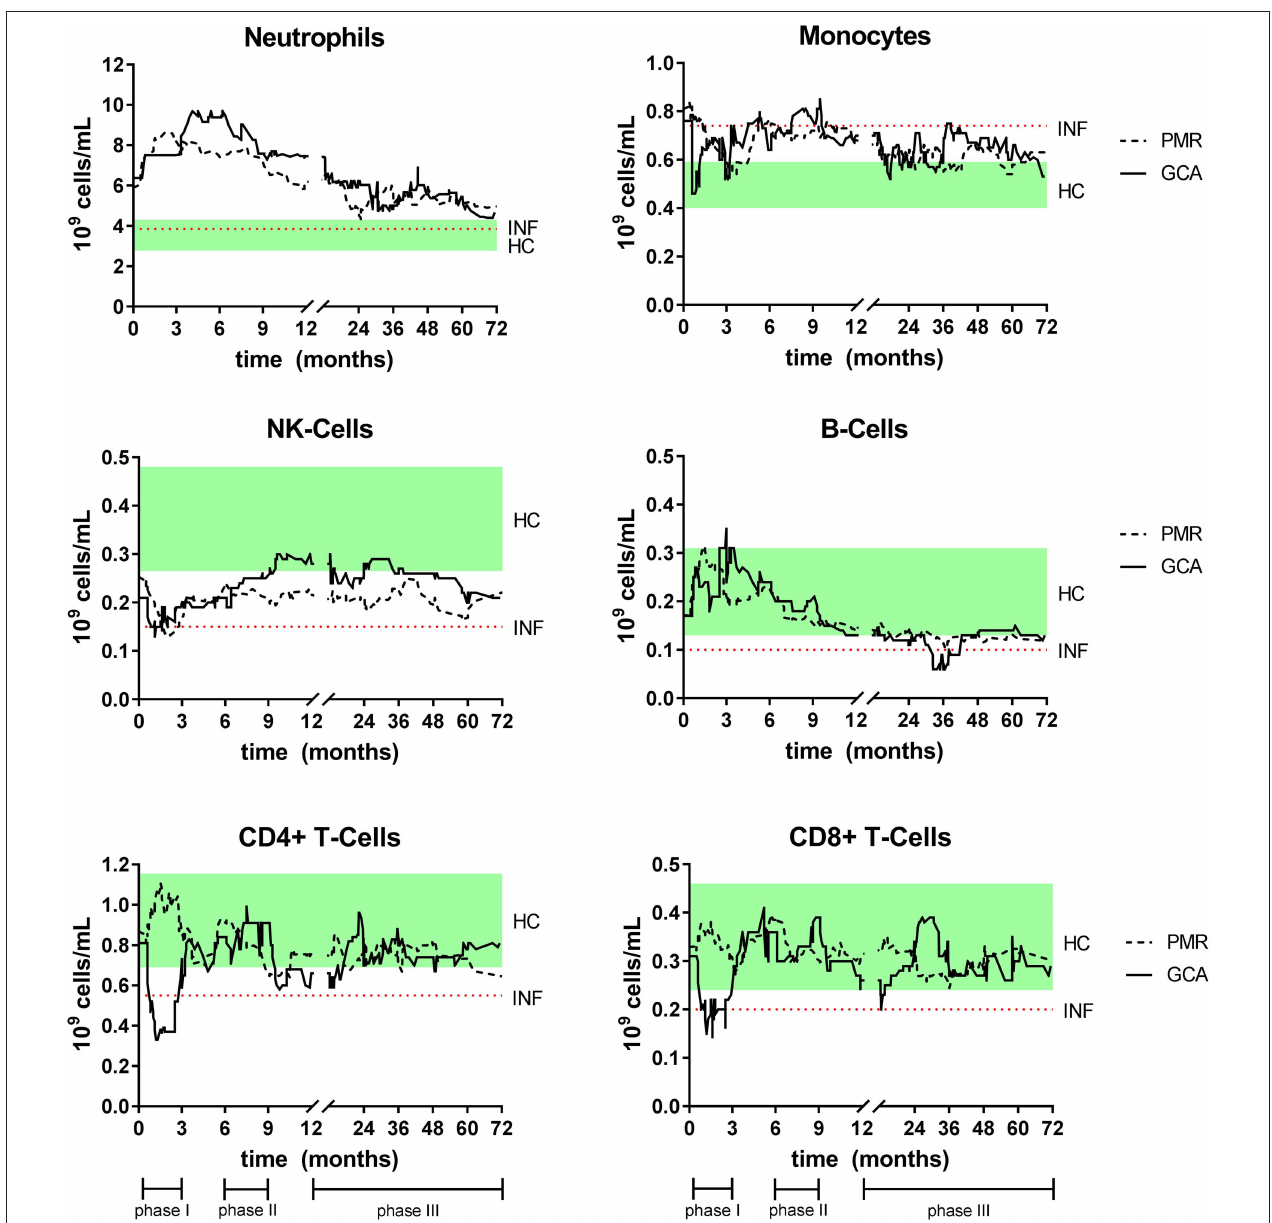
FIGURE 3 | Smoothed median of leukocyte counts for GCA and PMR patients over time while on GC treatment. The smoothed median is calculated by taking the median of each new measurement and that of the 19 measurements before that point. This method enables to distinguish patterns over time that would be unnoticeable if each point is plotted separately. For interpretation the interquartile range of HC (green box, cross-sectional measurement) and the median of the INF (dotted line, cross-sectional) were added to the figures. Time point 0 indicates the pre-treatment sample. Also, the three different treatment phases are